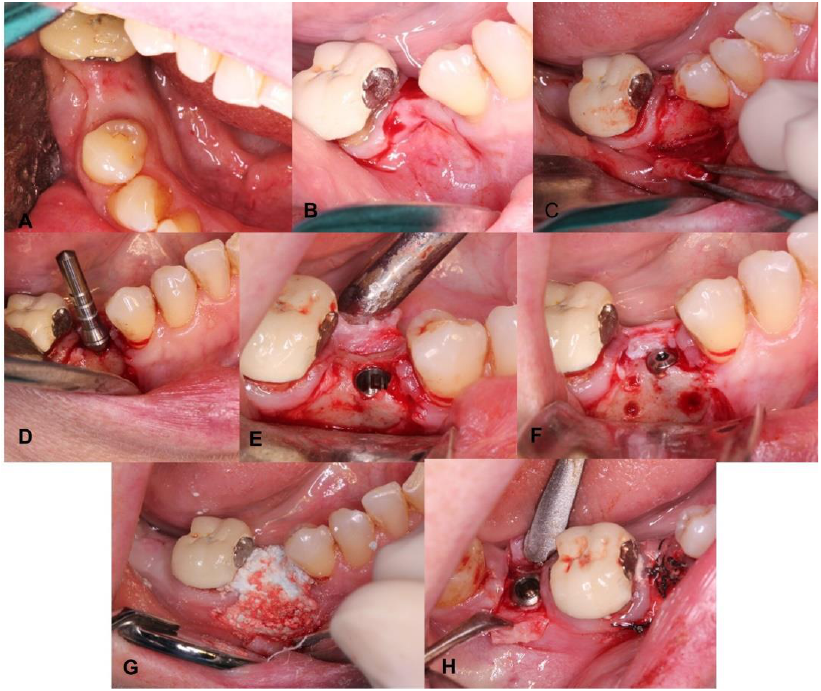
Figure 3. ( A ) Preoperative occlusal view; ( B ) Incision; ( C ) flap detachment; ( D ) Drilling according to protocol, check the position with the pin; ( E ) Implant placement at level 45; ( F ) Micro perforations in the vestibular; ( G ) Placement of Bond Apatite ® ; ( H ) Tension suture and implant placement in 47.